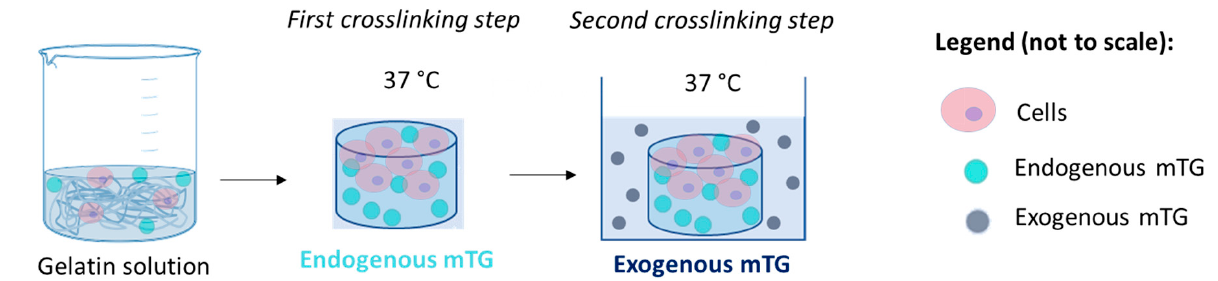
Figure 2. Preparation of the cell-laden gel, outlining the two crosslinking steps based on endogenous and exogenous mTG.